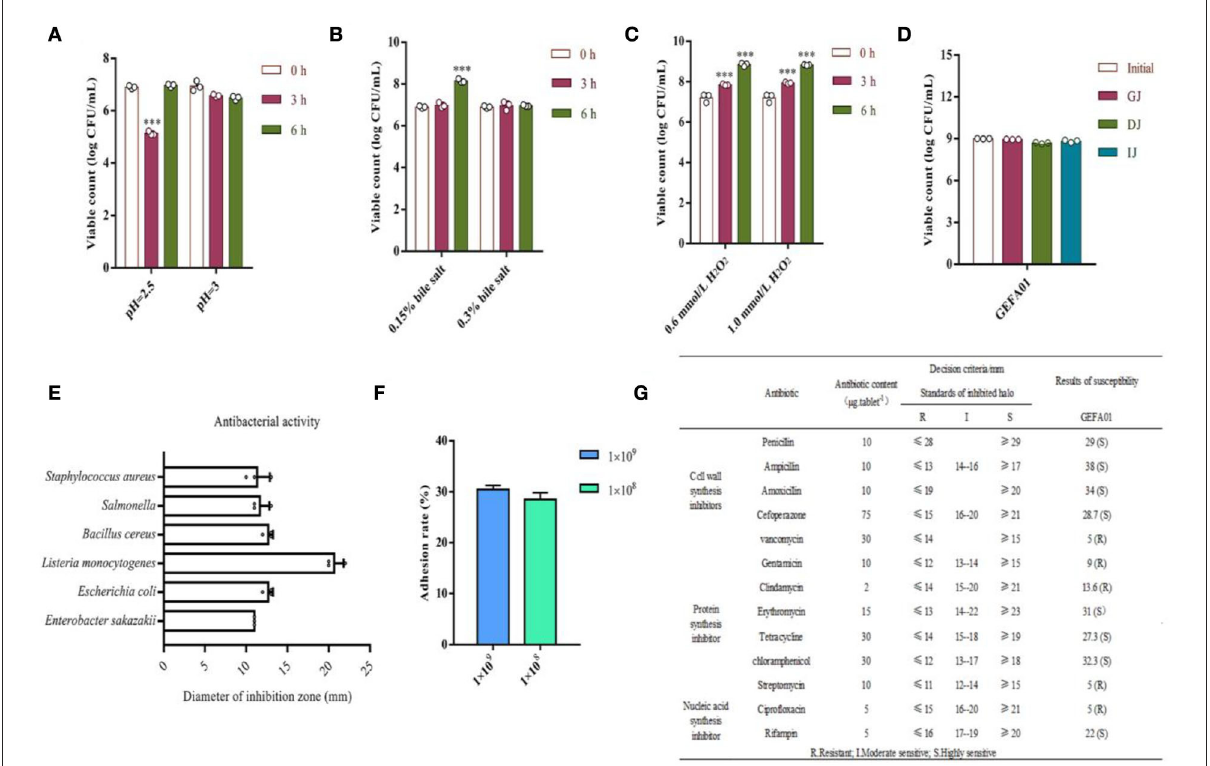
FIGURE2 Evaluation of the physiological properties of E. faecium GEFA01 in vitro . (A) Acid resistant; (B) bile salt tolerant; (C) H 2 O 2 resistant; (D) tolerance of simulated gastroenteric fluid; (E) antagonizing pathogenic bacteria; (F) adhesion rate to Caco-2 cells of different bacterial quantity; and (G) susceptibility tests to 13 antibiotics. Data were expressed as mean ± standard error of the mean (SEM). * p < 0.05, ** p < 0.01, *** p < 0.001. Tests were performed in triplicate.